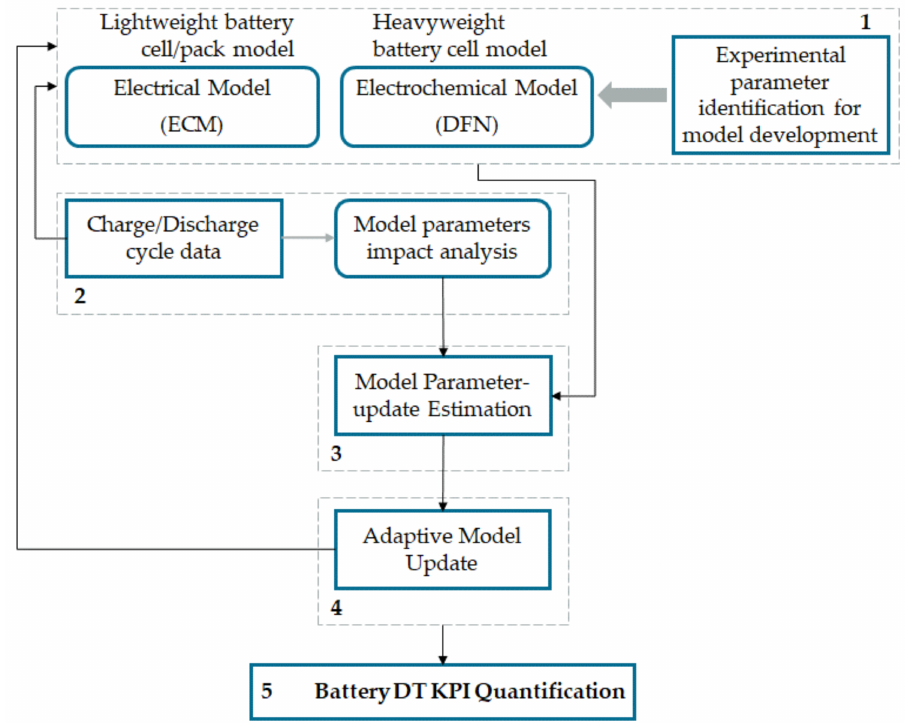
Figure 2. Approach for battery DT